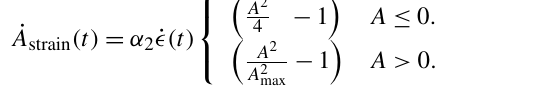
values of A , no modification is applied. This leads